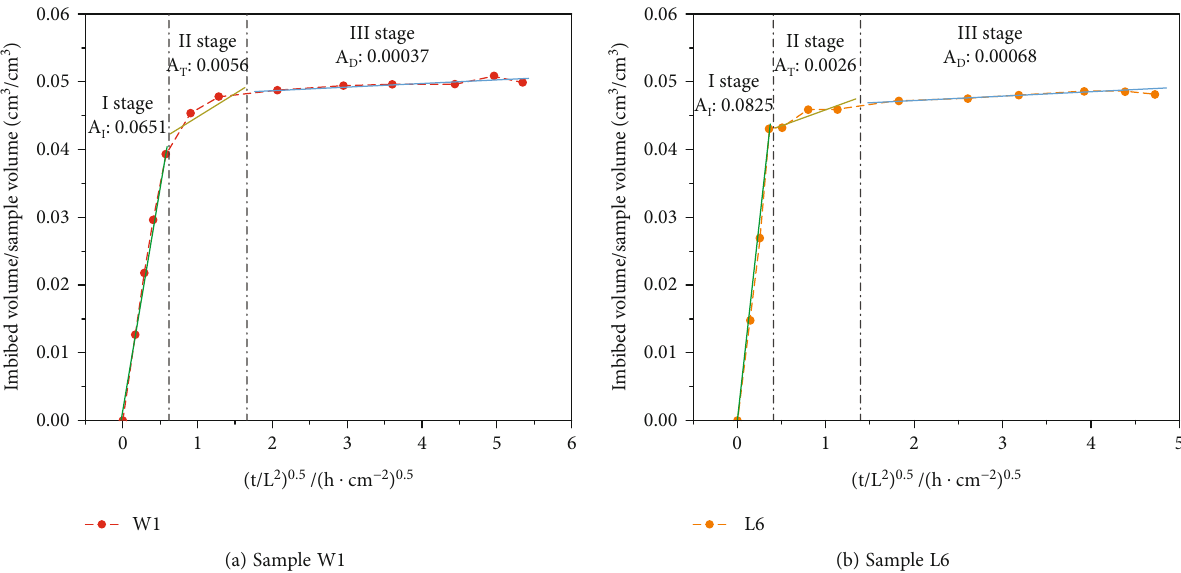
ffiffiffiffiffiffiffiffi p in NaCl solution with a salinity of Cl - of 15,000 t / L 2